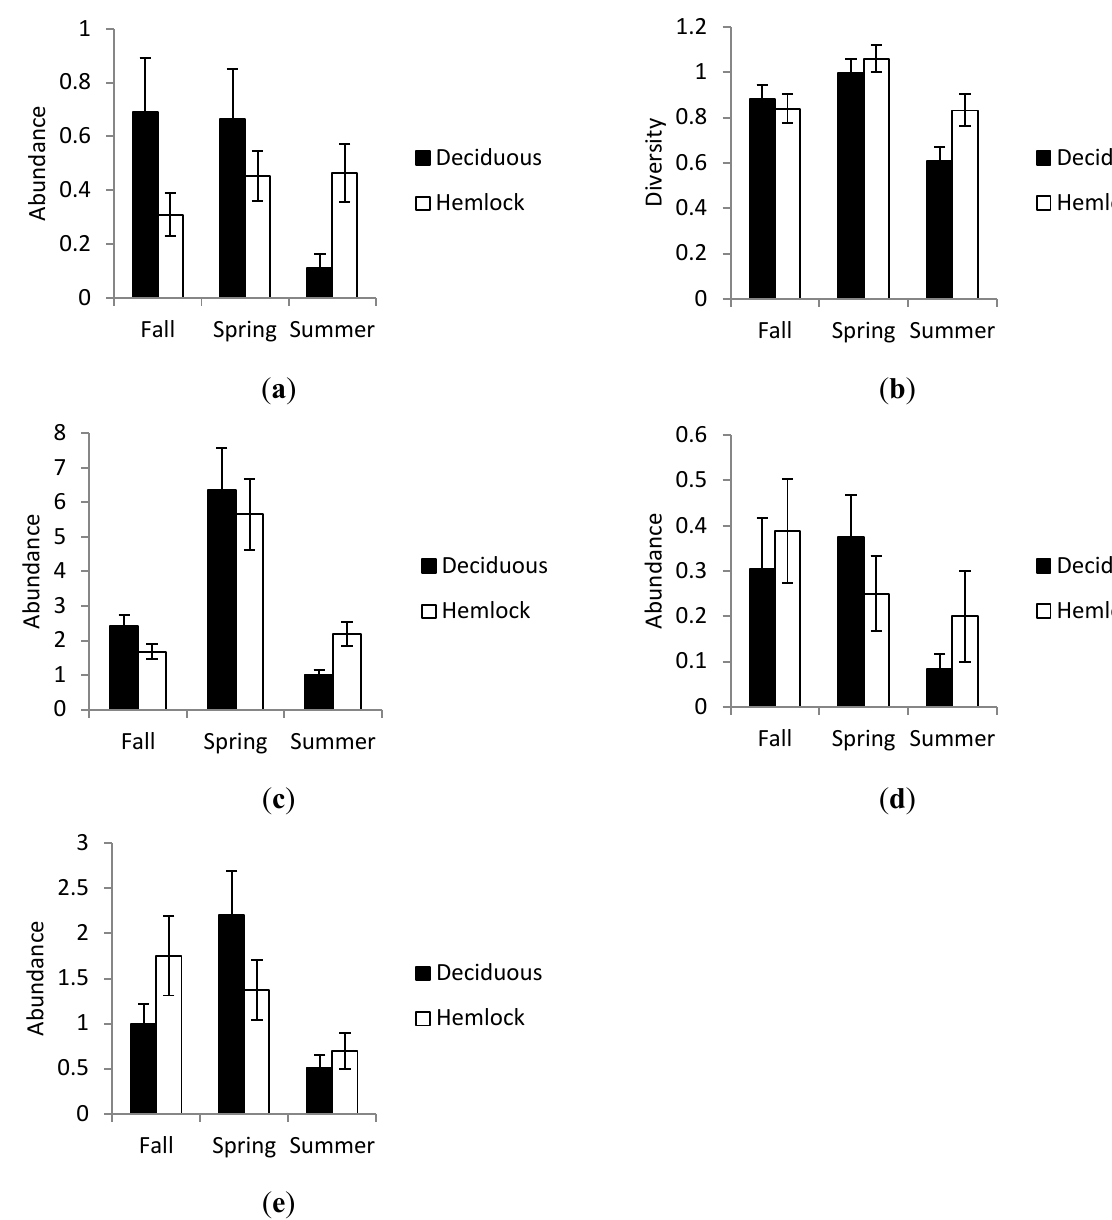
Figure 2. Interactions between riparian vegetation and season influences ( a ) abundance of Elmidae; ( b ) Shannon index of diversity; and ( c ) abundance of scrapers, sampled via kick nets, 2009–2010; and ( d ) Heptageniidae and ( e ) collector-gatherers, sampled via Hester-Dendy, fall 2009–summer 2010, from streams dominated by deciduous (■) and eastern hemlock (□) riparian